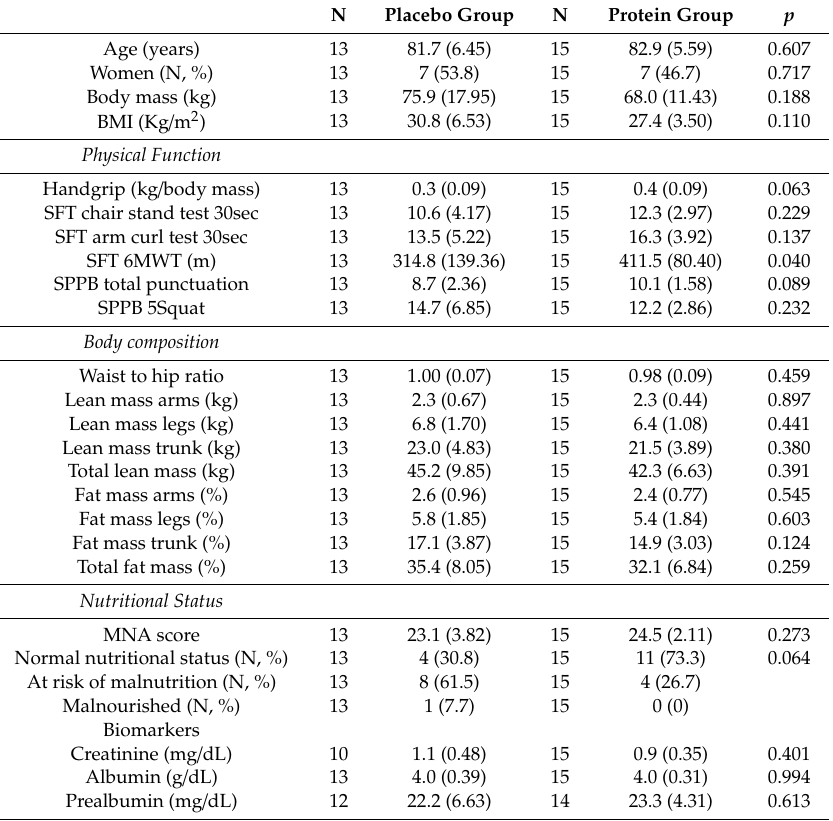
Table 2. Characteristics of participants completing the study (intend-to-treat analyses).